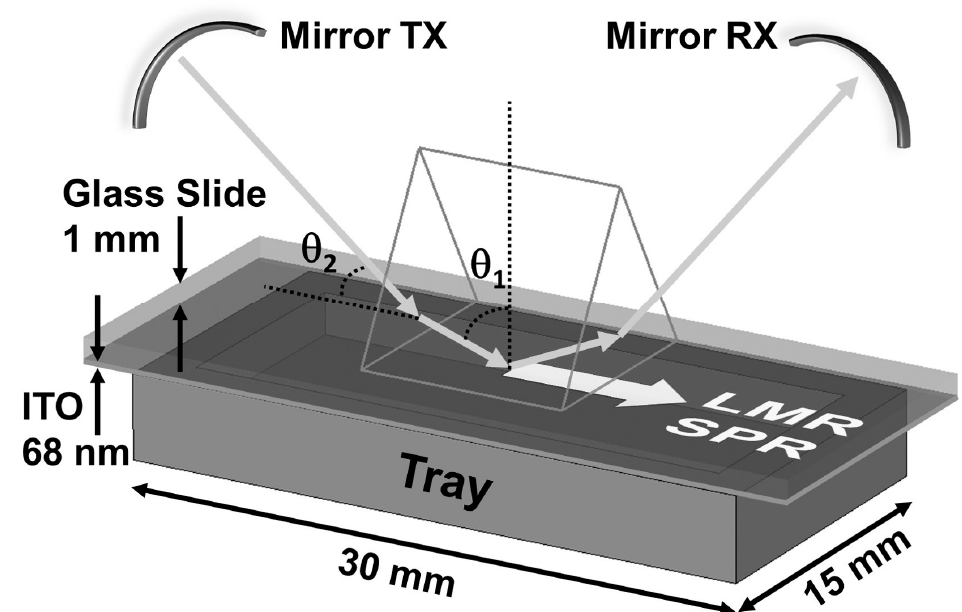
Figure 5. Example of a Kretschmann configuration for the analysis of SPR and LMR. In this case, the polarized light coming from the transmitting mirror TX is coupled through a prism to a coated glass slide so that the light beam is reflected in the interface at the desired angle θ 1 . The coated side is facing a sample tray containing the media whose refractive index is being measured. The reflected beam is collected by the receiving mirror RX. Reprinted from [17] with permission from AIP Publishing.